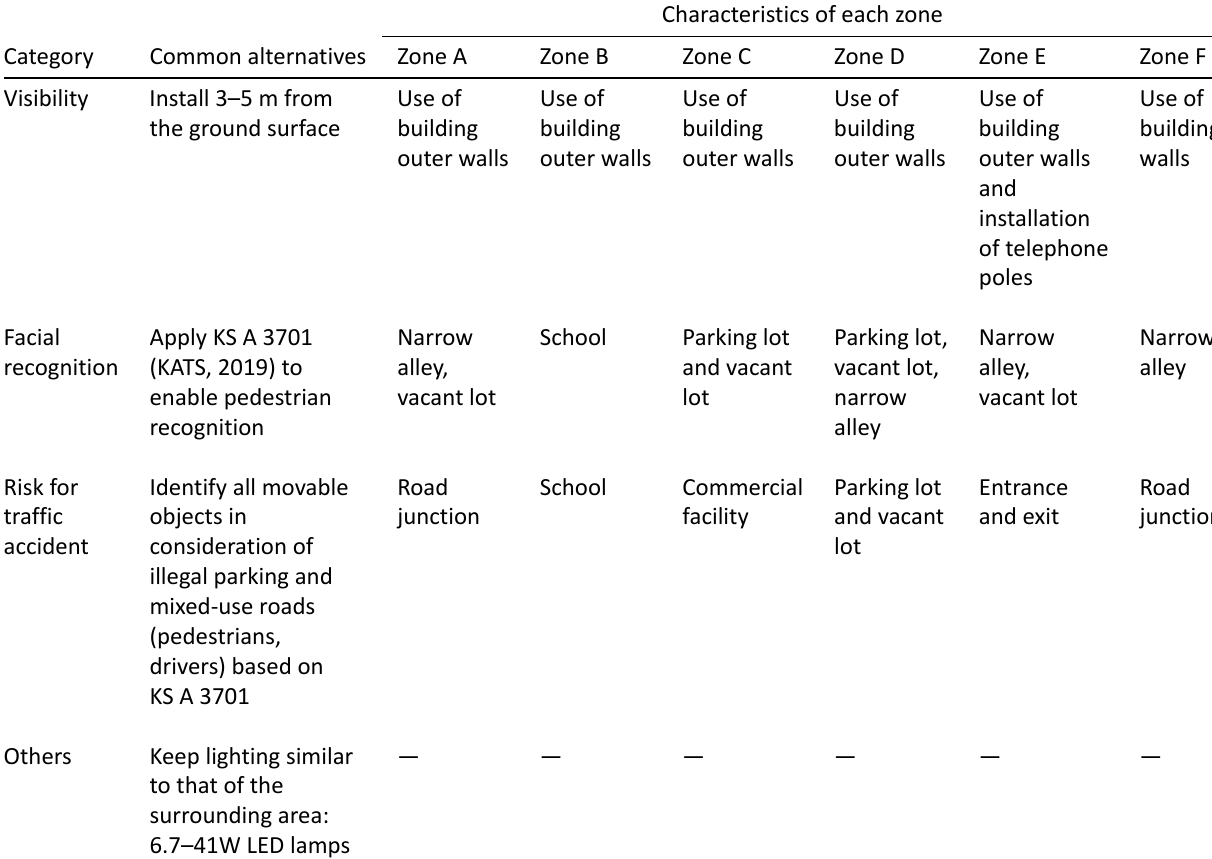
Table 2. Natural surveillance alternatives through street